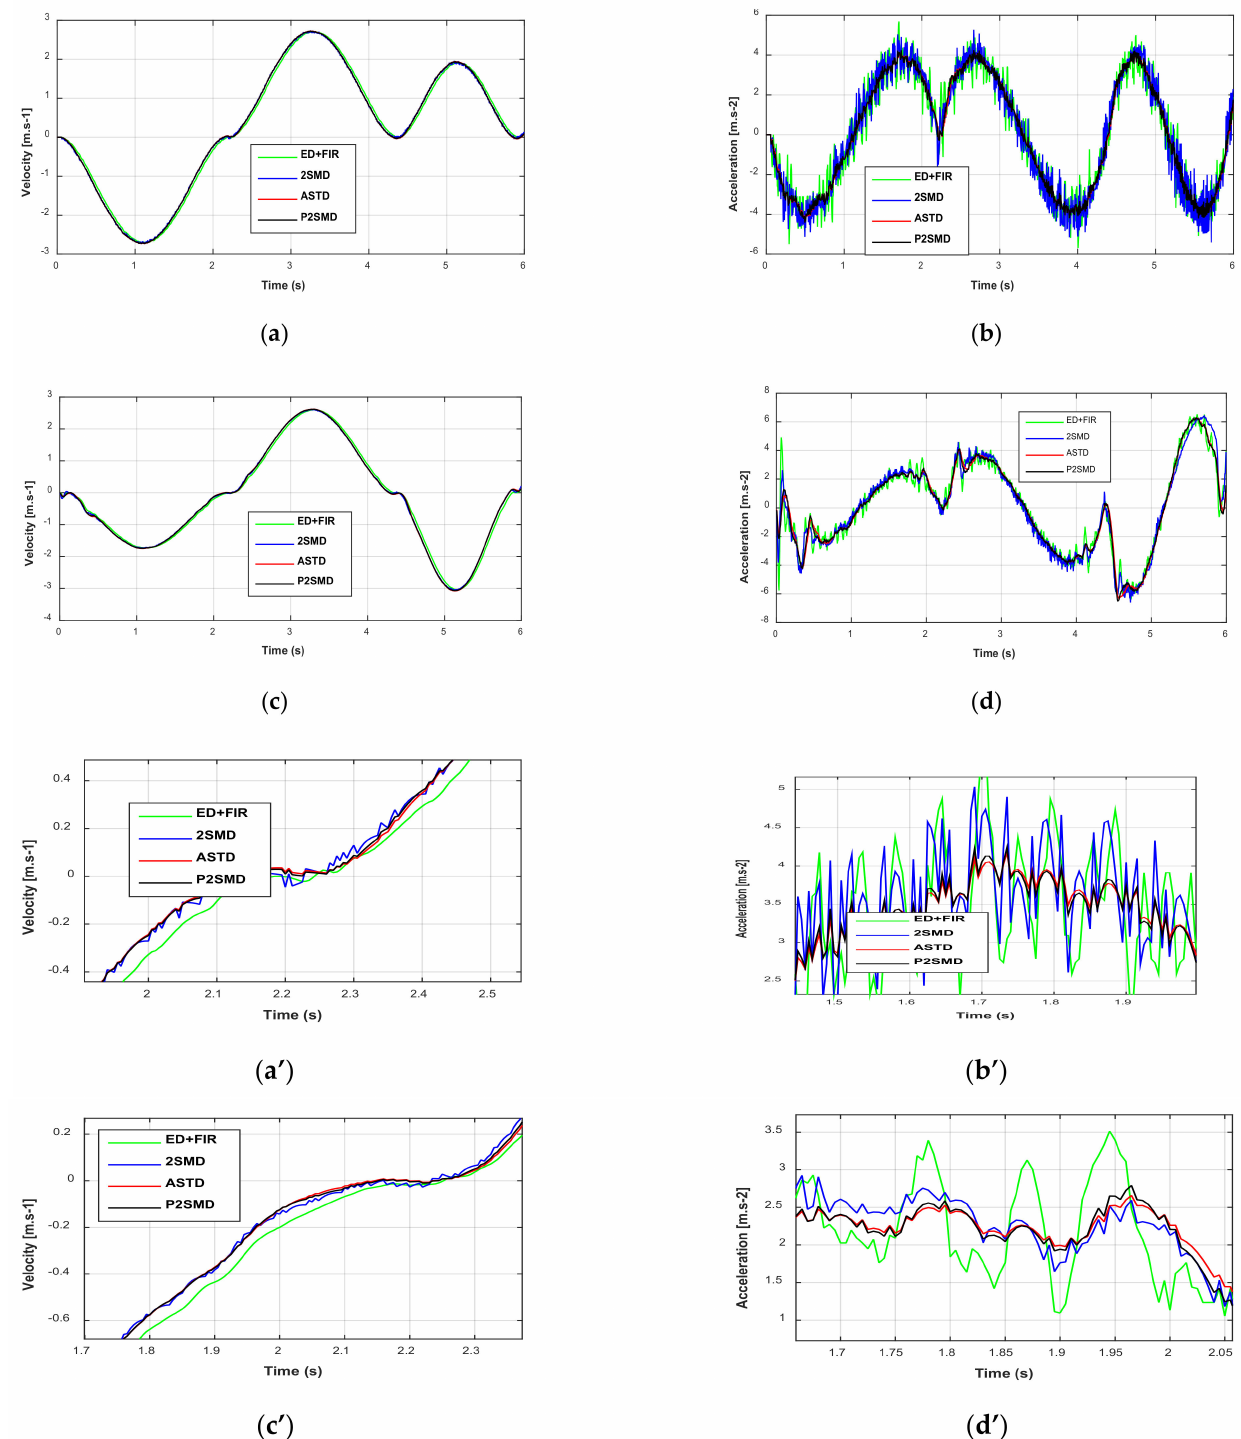
Figure 4. Estimated velocities and accelerations: ( a ) Time evolution velocities for joint 1; ( b ) Time evolution accelerations for joint 1; ( c ) Time evolution velocities for joint 2; ( d ) Time evolution accelerations for joint 2. Zoom of estimated velocities and accelerations: ( a’ ) Time evolution velocities for joint 1; ( b’ ) Time evolution accelerations for joint 1; ( c’ ) Time evolution velocities for joint 2; ( d’ ) Time evolution accelerations for joint